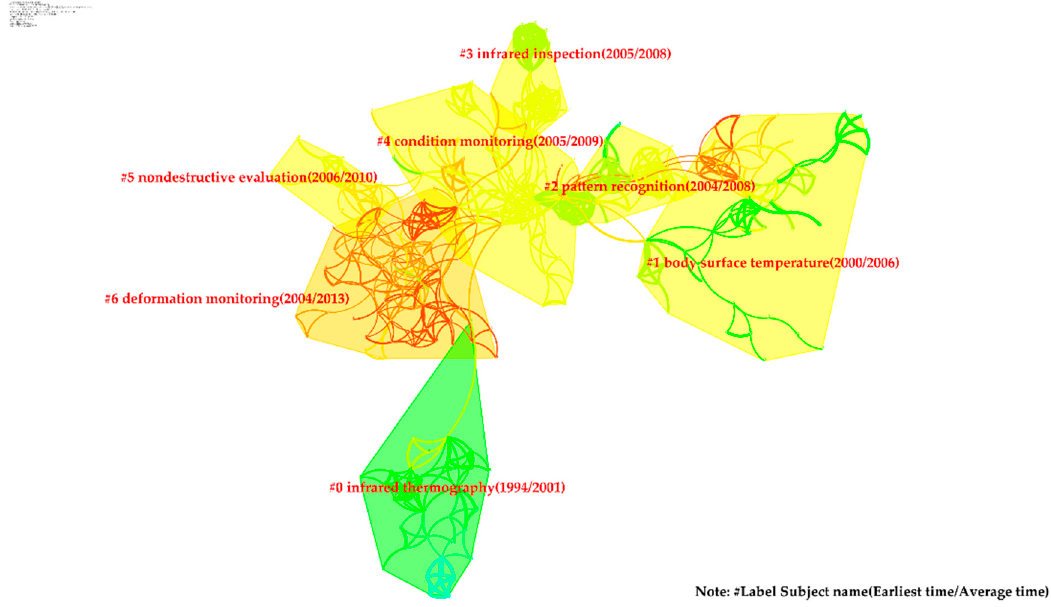
Figure 10. Keyword evolution co ‐ occurrence knowledge map of infrared detection technology studies.